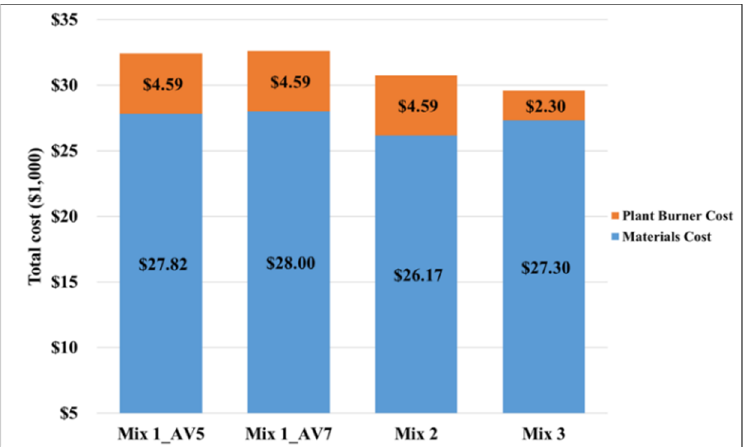
Figure 6. Cost comparison for all the mixes based on materials and burner fuel cost (costs calculated for a 1.61 km roadway section with a single 3.7 m wide lane and 50.8 mm of compacted asphalt concrete layer thickness).